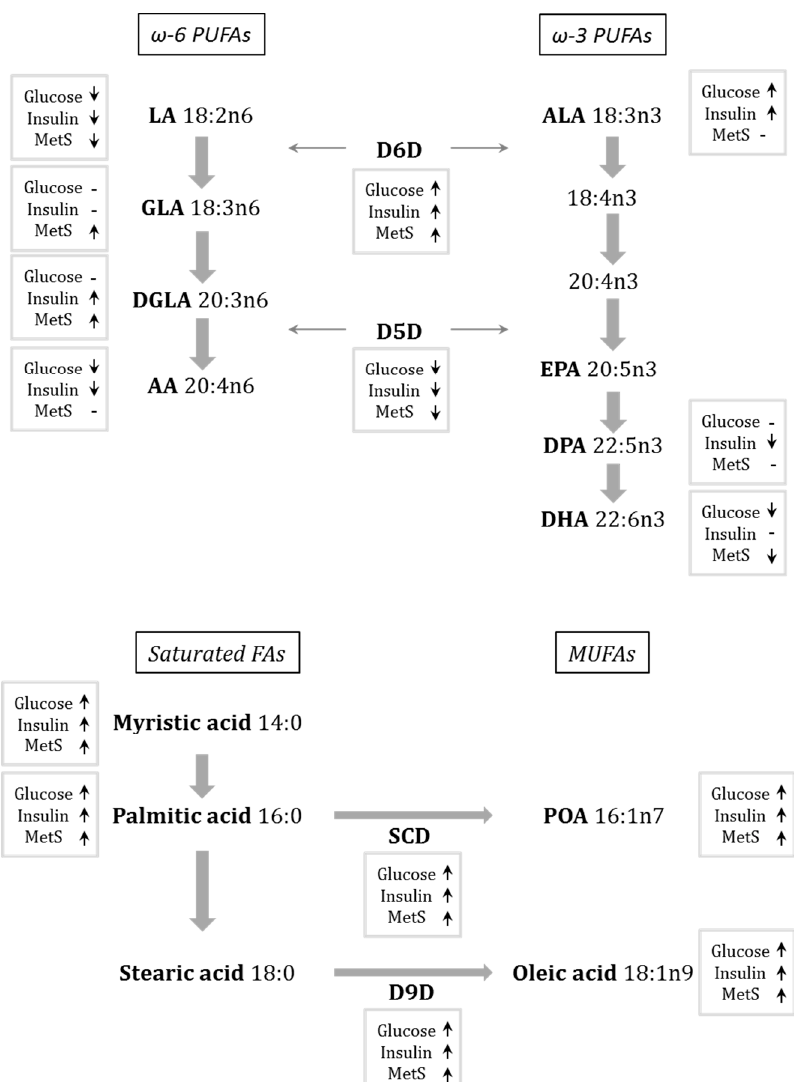
Figure 1. Summary of results from serum fatty acid (FA) profiling in women 6 years after GDM. Arrows shows whether the FA or desaturase had a positive (arrow up), or negative (arrow down) correlation with glucose values (fasting or AUC), with insulin (fasting or AUC) after BMI adjustment, or with at least two parameters of MetS (high BMI, low HDL cholesterol, high blood pressure, high waist circumference, or high body fat percentage). AA, arachidonic acid; ALA, α -linolenic acid; AUC, area under the curve; BMI, body mass index; D5D, delta-5 desaturase; D6D, delta-6 desaturase; D9D, delta-9 desaturase; DGLA, dihomo- γ -linolenic acid; DPA, docosapentaenoic acid; DHA, docosahexaenoic acid; EPA, eicosapentaenoic acid; GLA, γ -linolenic acid; HDL, high-density lipoprotein; LA, linoleic acid; MUFA, monounsaturated fatty acid; POA, palmitoleic acid; PUFA, polyunsaturated fatty acid; SCD, stearoyl-coenzyme A desaturase.